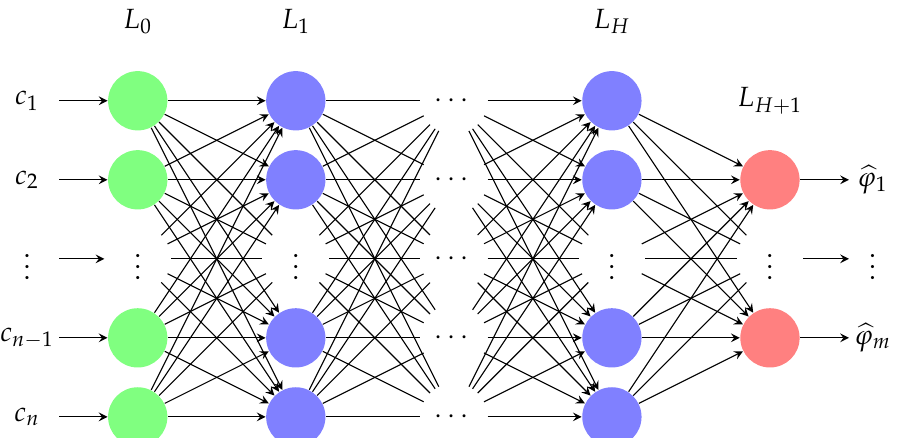
Figure 4. MLP archetype. The units of the input layer L 0 are in green, the units of the hidden layers L 1 , . . . , L H are in purple, and the units of the output layer L H + 1 are in red.